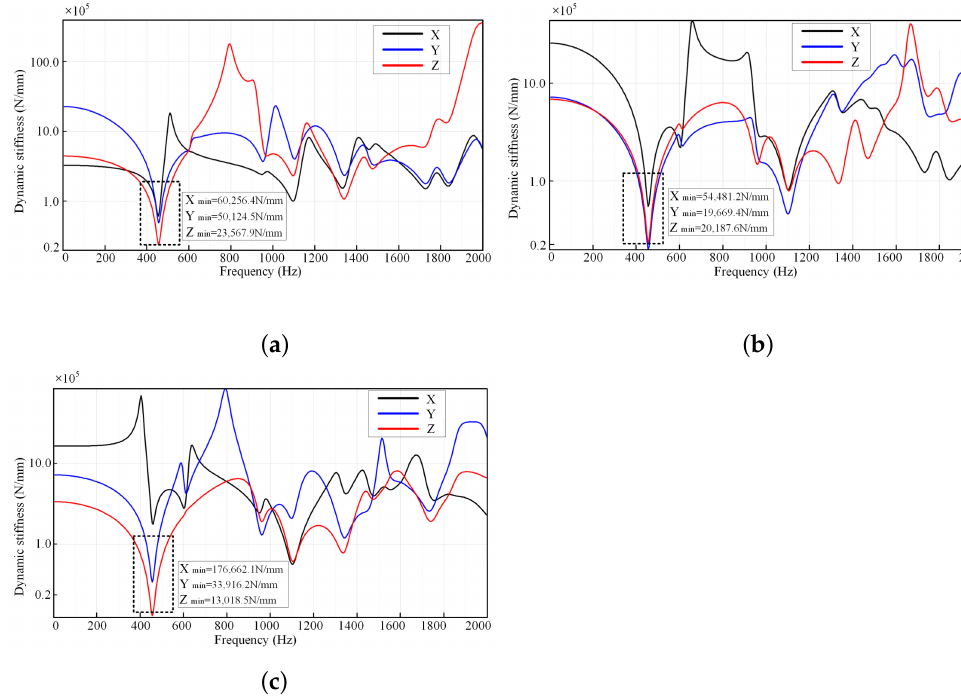
Figure 12. Dynamic stiffness simulation analysis results of gearbox housing. ( a ) Stiffness curve of output end of front gearbox housing. ( b ) Stiffness curve of intermediate end of rear gearbox housing. ( c ) Stiffness curve of output end of rear gearbox